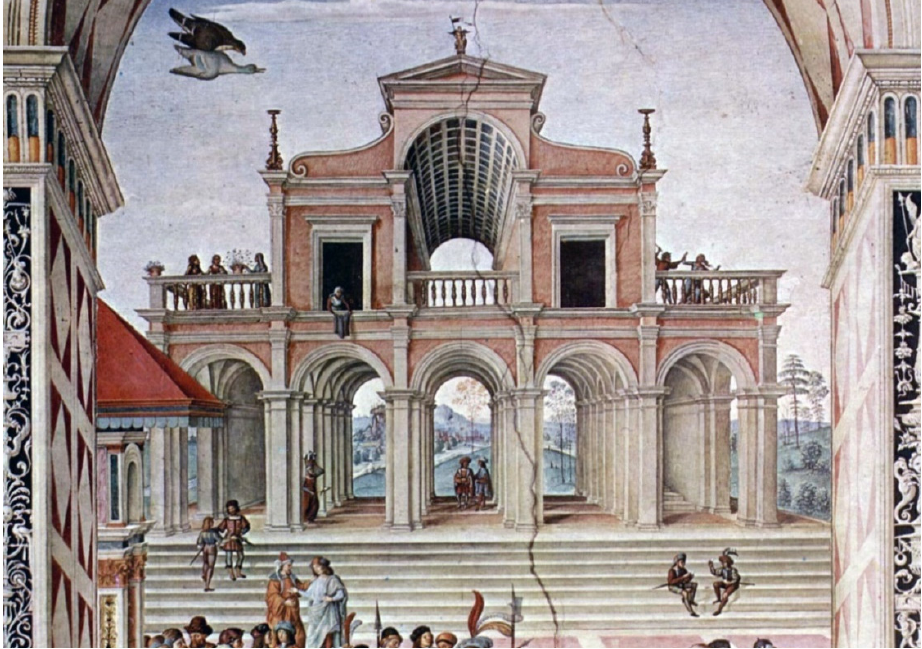
Figure 5. Pinturicchio (and Raffaello?), Detail from The Coronation of Enea Silvio Piccolomini, 1502–1507, Piccolomini Library, Siena.